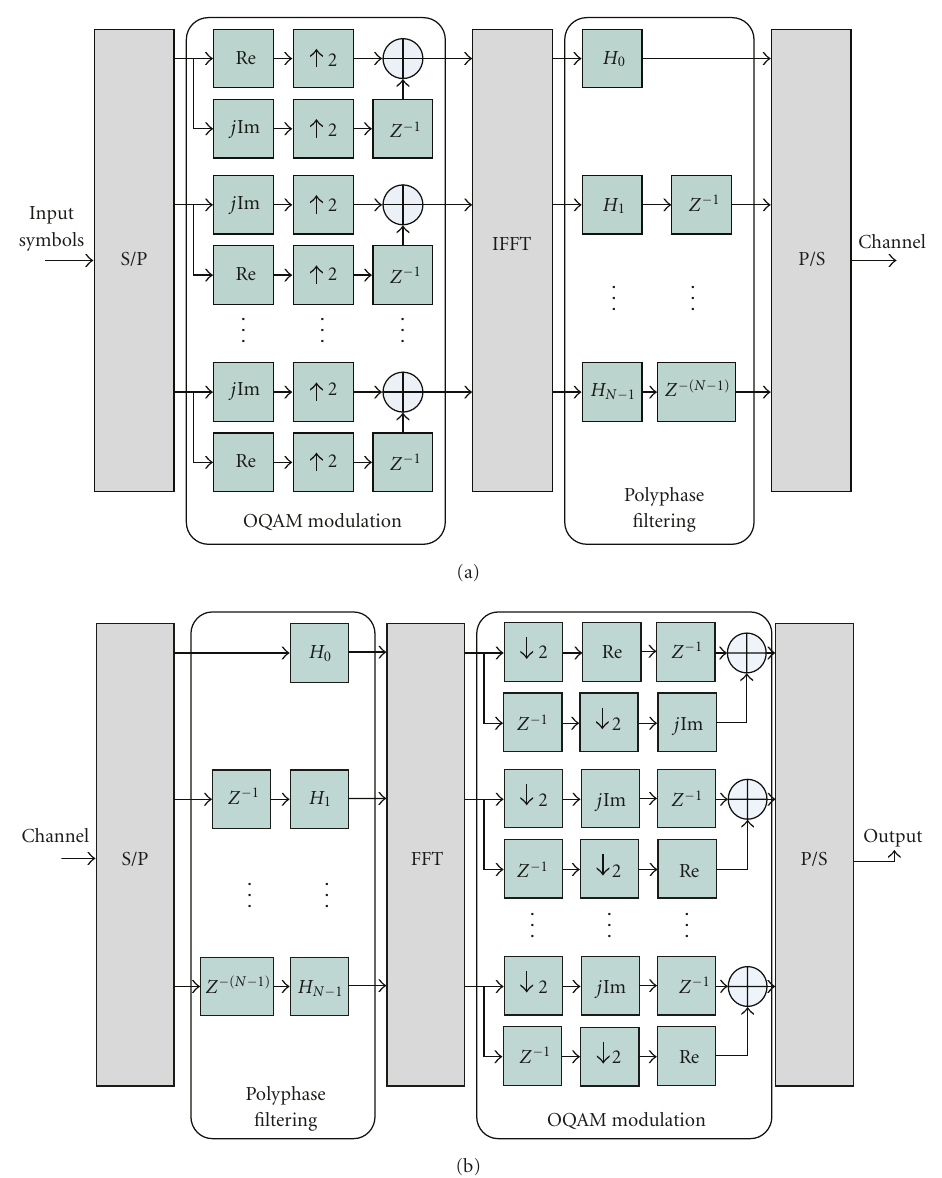
Figure 3: FBMC system’s transmitter and